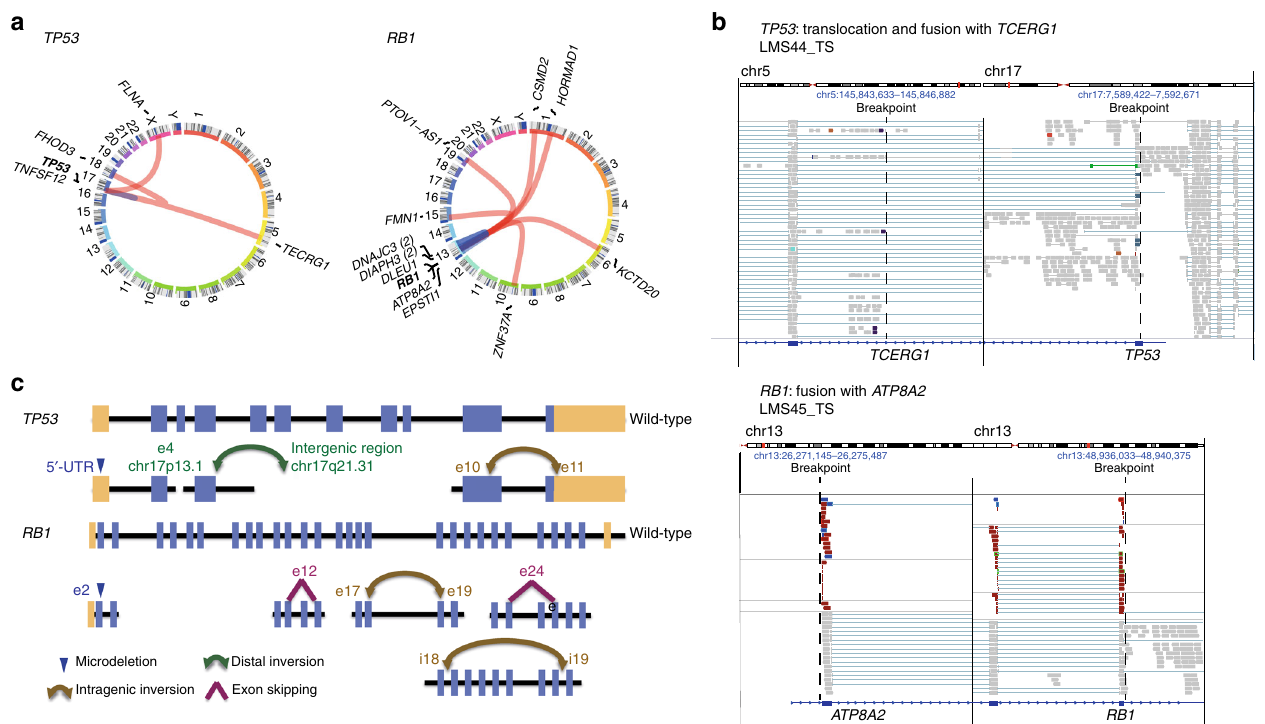
Fig. 4 Genetic lesions targeting TP53 and RB1 in adult LMS. a Structural variant plots of all fusion transcripts involving TP53 and RB1 detected in 37 tumors. b Interchromosomal rearrangement resulting in a non-functional TP53 - TCERG1 fusion transcript in case LMS44 (top) and intrachromosomal rearrangement resulting in a non-functional RB1 - ATP8A2 fusion transcript in case LMS45 (bottom). TS transcriptome sequencing, chr chromosome. c Schematic representation of different genetic lesions targeting TP53 and RB1 . e exon, i intron, chr chromosome, UTR untranslated